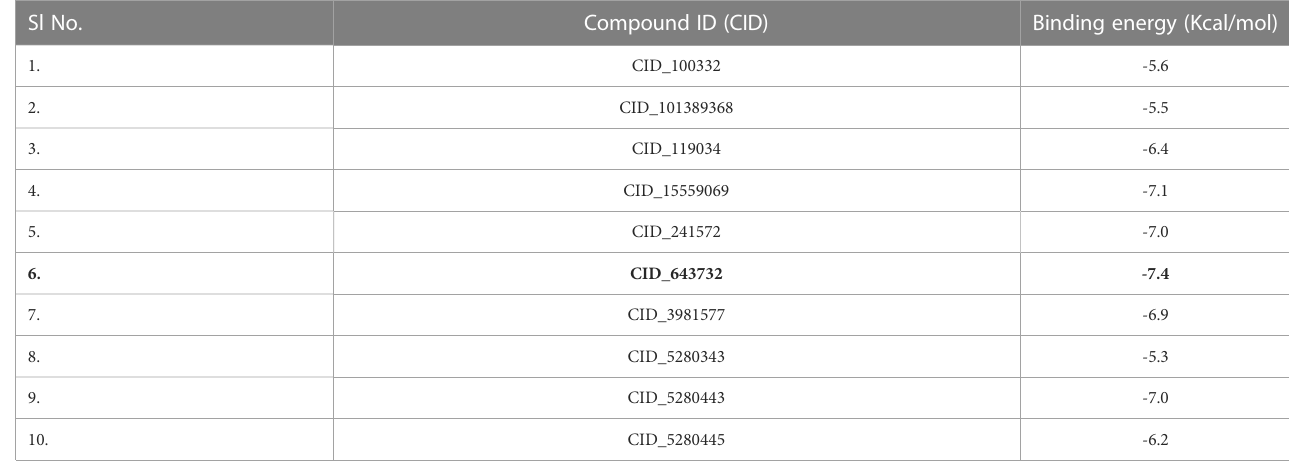
TABLE 1 Molecular Docking of 10 selected phyto-compounds. Sl No.